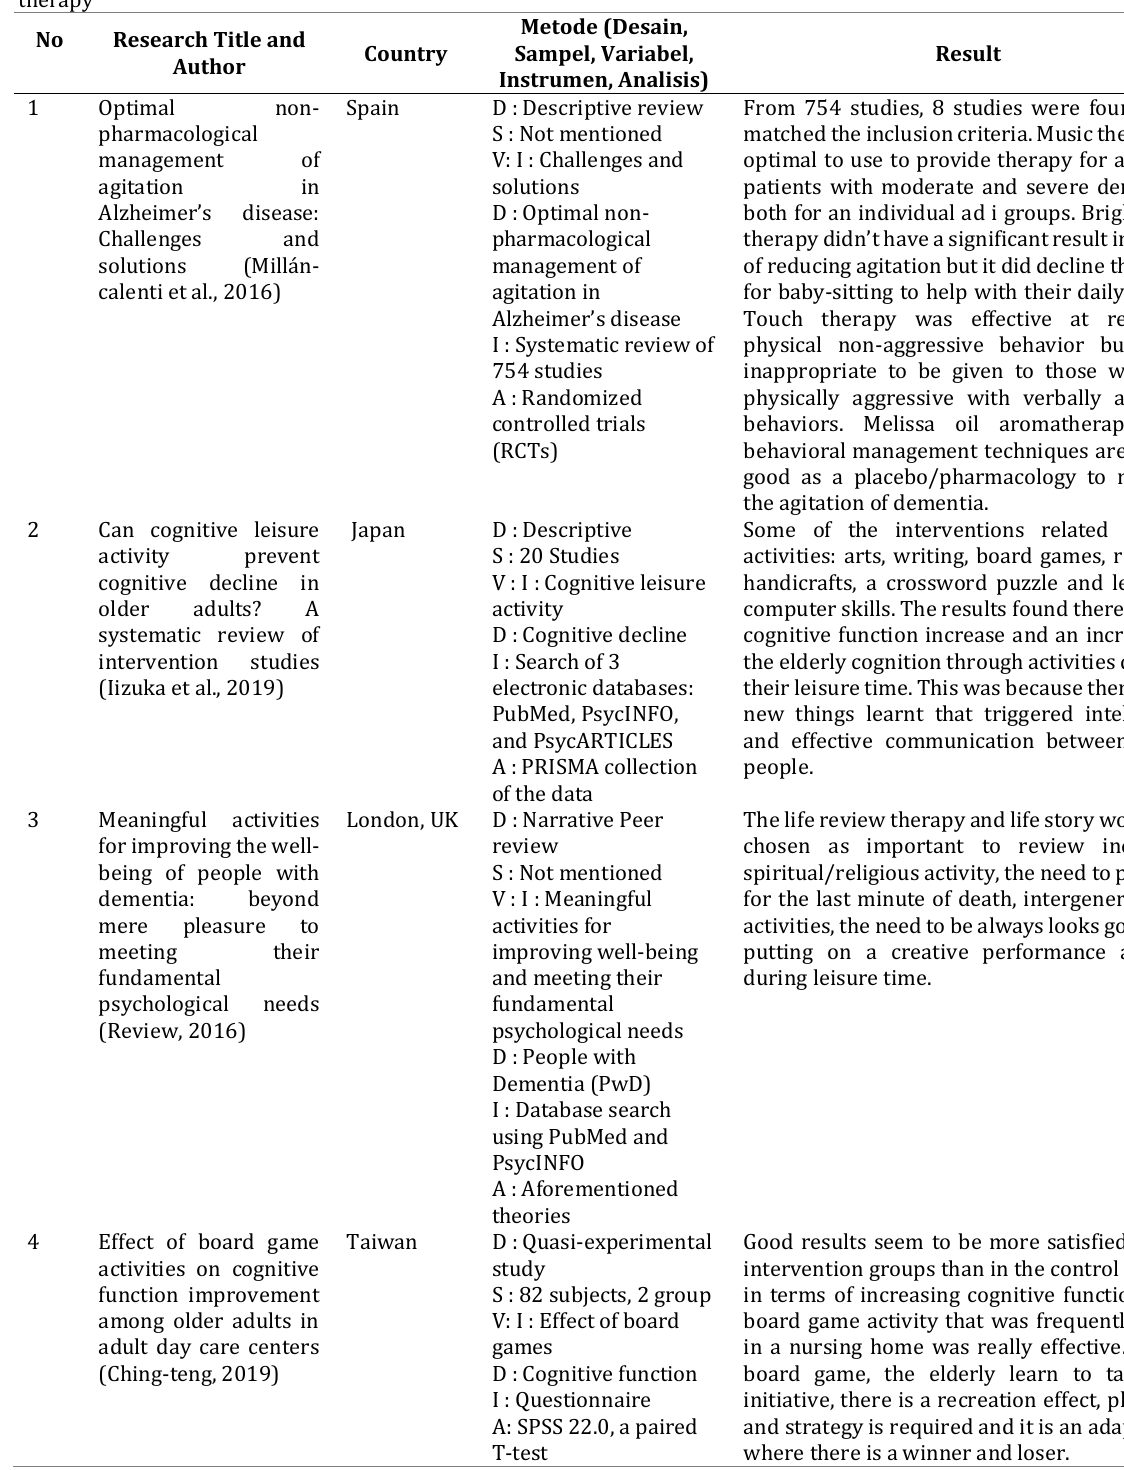
Table 1. Summary of the non-pharmacological therapies for the elderly to prevent dementia through cognitive